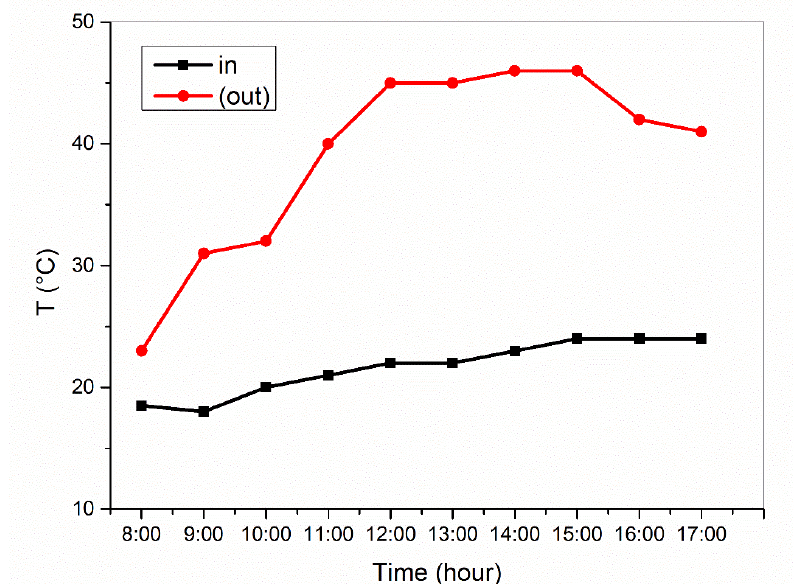
Figure 5: Temperature change during the day hours of the two systems without coating measured at 02.02.2021 .